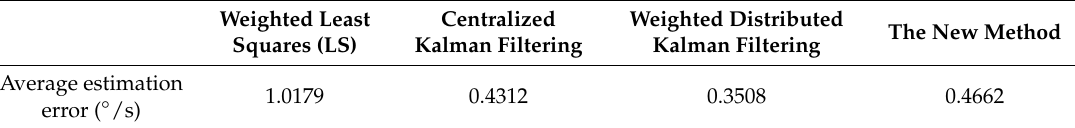
Table 3. The average estimation error of di ff erent fusion method in the